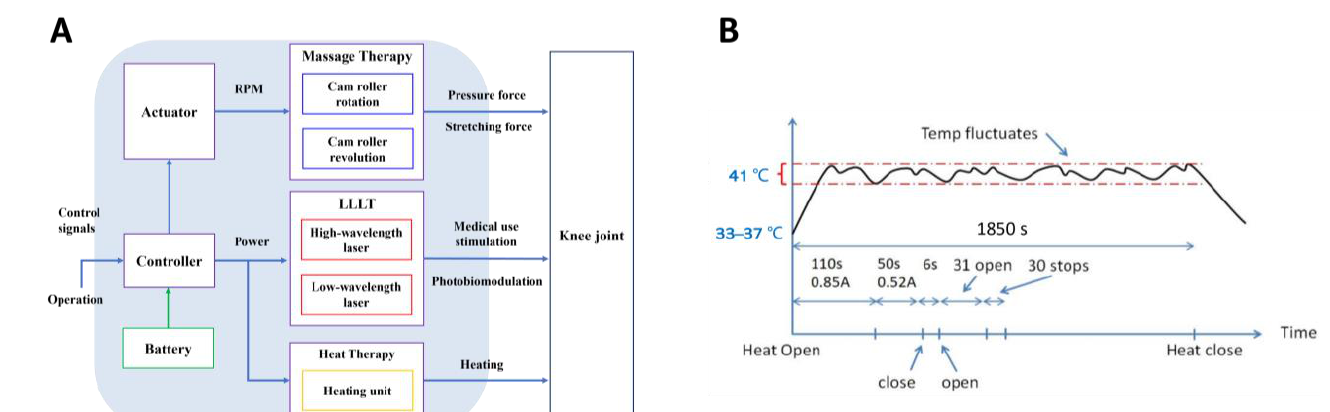
Figure 3. Control system for hybrid therapeutic device. ( A ) Schematic diagram of the therapeutic device system; ( B ) Methodology of the heat therapy system control used to keep the skin surface temperature at 41 degrees centigrade.